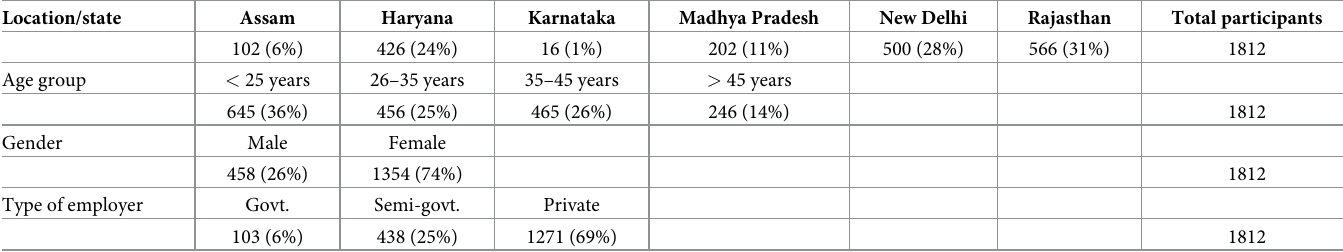
Table 1. Demographic details of